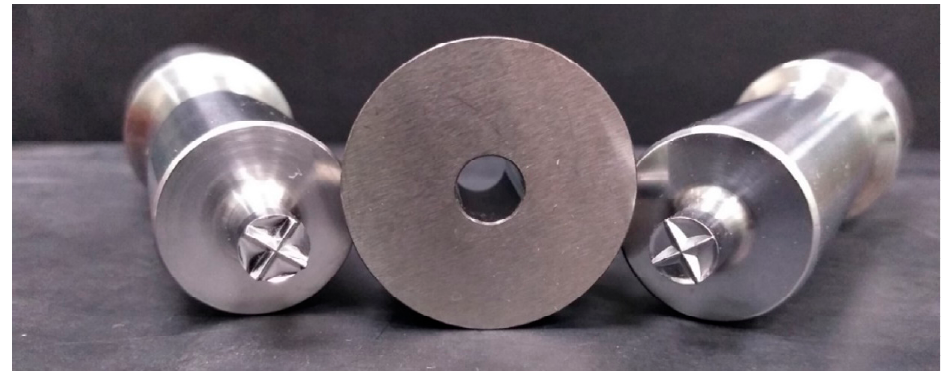
Figure 1. EBT ( left ) and TBT ( right ) upper punches with the relevant die.